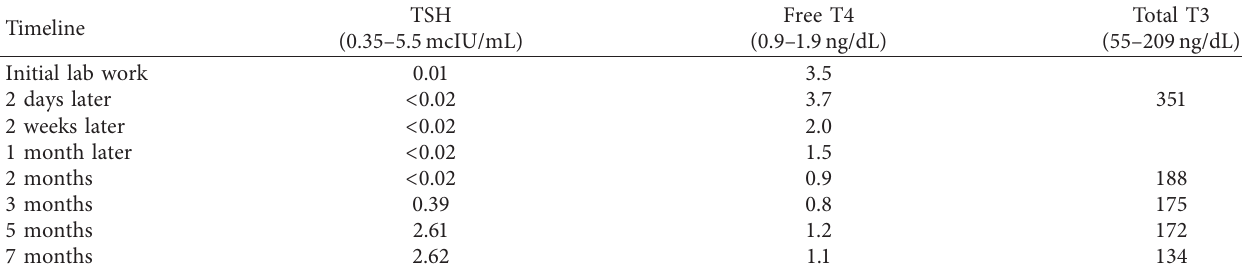
Table 1: Hormonal profile of the patient with gradual improvements of thyroid hormone levels from being hyperthyroid to euthyroid.